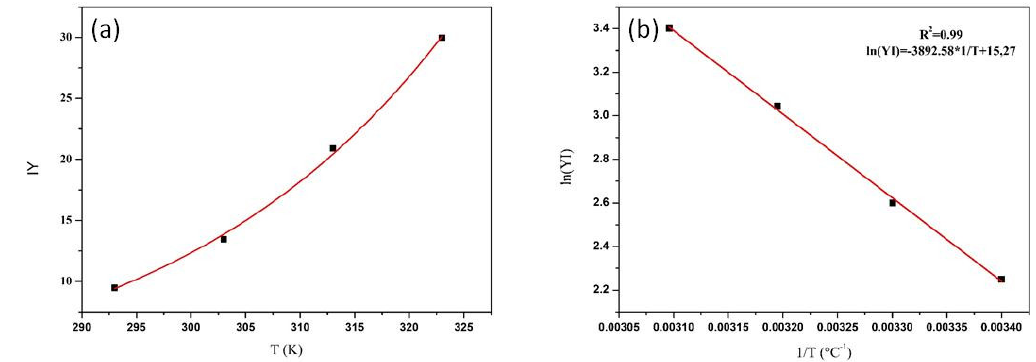
Figure 6. Yield of immobilization plotted versus T (squares) and exponential growth fit (line) ( a ) and Arrhenius plot ( b ).